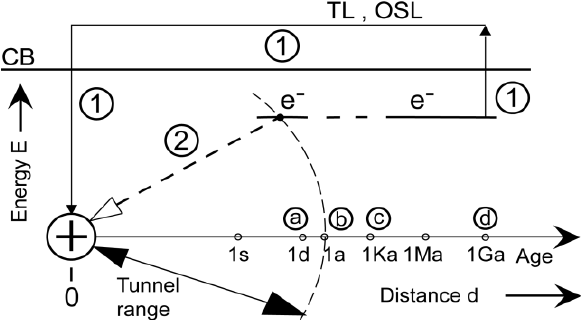
Fig. 1 . The gruyère or Swiss cheese model of tunnelling- induced luminescence in a solid. From